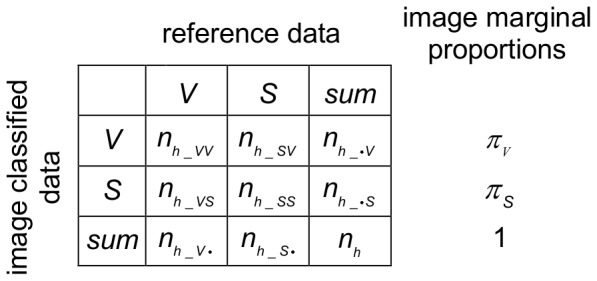
Confusion matrix.The matrix is calculated for the   = 24 reference pixels of each of   = 16 gray value-strata of a hemispherical photograph. Column and row sums show how many pixels were classified by a binarization algorithm (image classified data) and by an operator (reference data) into the categories vegetation (V) and sky (S). The four central cells show how many pixels were classified by an algorithm and the operator in agreement (, ) and in disagreement (, ). The image marginal proportion displays the overall fraction of pixels classified by the algorithm as vegetation () or sky () within the respective stratum. Adapted from Congalton and Green 2009.